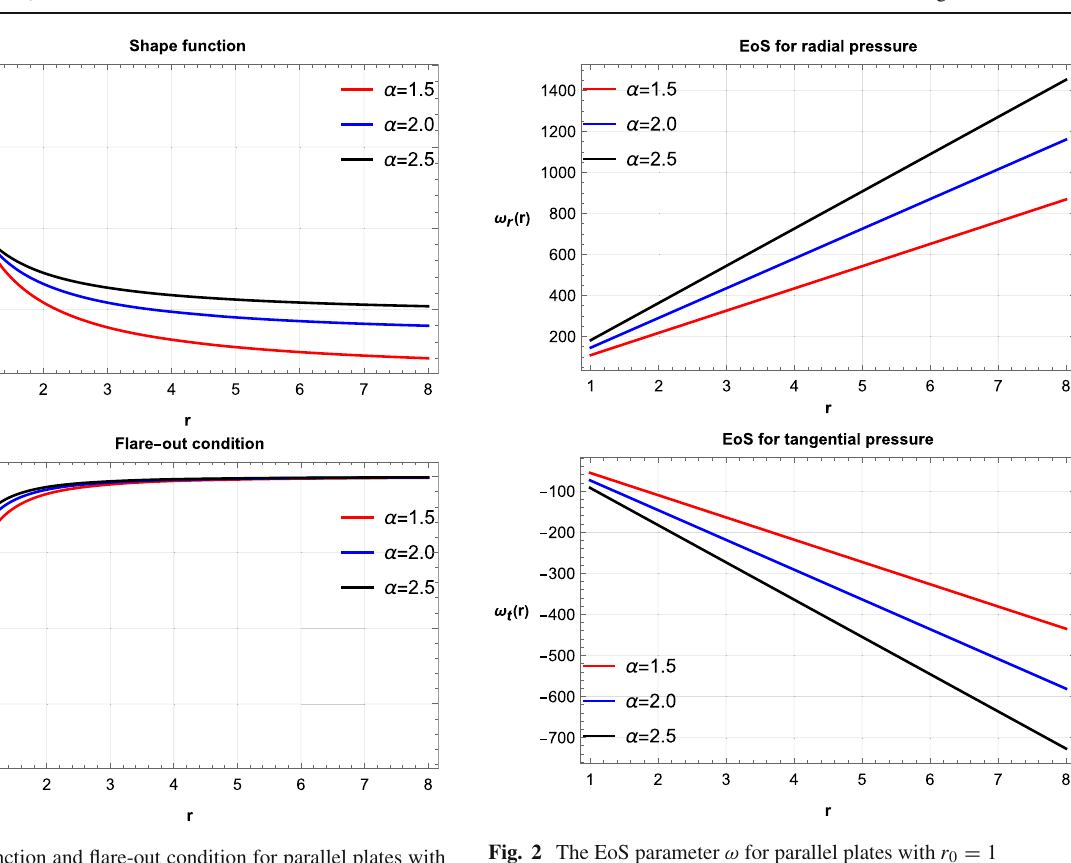
Fig. 2 The EoS parameter ω for parallel plates with r 0 =